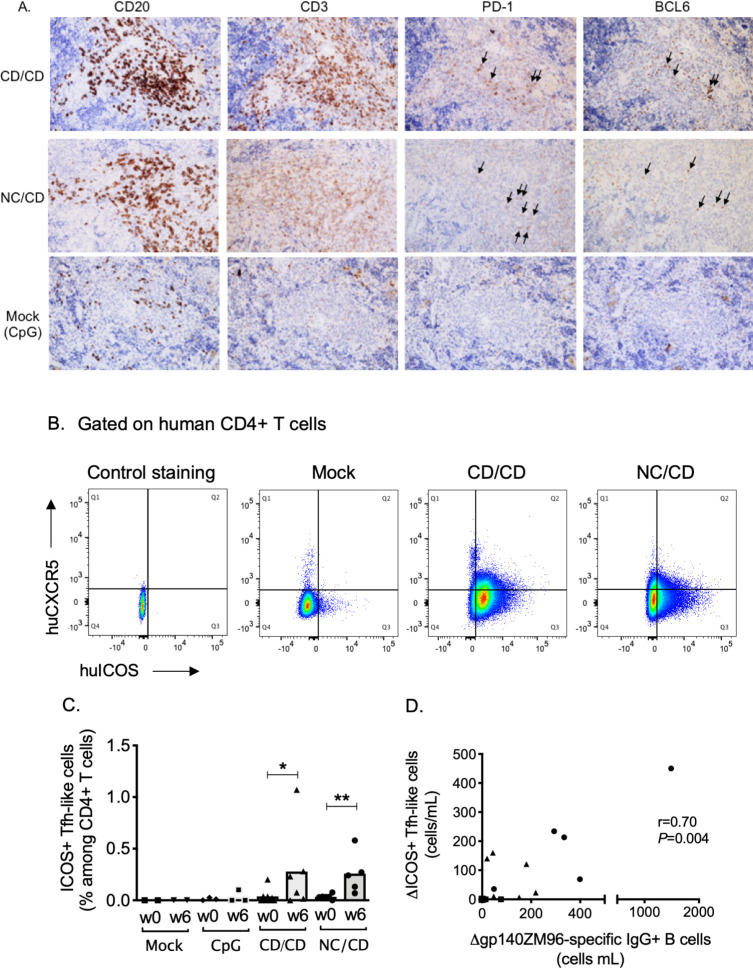
The CD/CD and NC/CD vaccination regimens elicit human memory Tfh cells that correlate with the expansion of gp140-specific human B cells.(A) Representative immunohistochemistry images of spleen sections from vaccinated hu-mice (NC/CD and CD/CD groups) and control animals that received CpG-B only (mock group). (B) Gating strategy for the evaluation of circulating human memory Tfh cells. Dot blots show concatenated data from mock hu-mice (n = 5), CD/CD (n = 6) or NC/CD (n = 5) vaccinated hu-mice one week after the last injection (w6). The human CD4+ T cells (see their gating strategy in the S1 Fig) were represented in a huCXCR5 versus huICOS dot blot to identify the subset of human memory blood ICOS+ Tfh cells. Control of hCXCR5 and hICOS staining was obtained by gating on mouse cells. (C) Frequency of human ICOS+ CXCR5+ Tfh cells in the blood of hu-mice. Individual values are presented, along with the median. Mann-Whitney U-tests were used for comparisons between w0 and w6 values obtained in immunized hu-mice. *p < 0.05, **p < 0.01. (D) Correlation between the increase in blood gp140-specific IgG+ hu-B cells (x axis) and the increase in blood ICOS+CXCR5+ hu-Tfh cells; hu-mice from the NC/CD group are represented as circles, hu-mice from the CD/CD group as triangles, and control groups as squares. Spearman’s rank test was used to assess correlations.